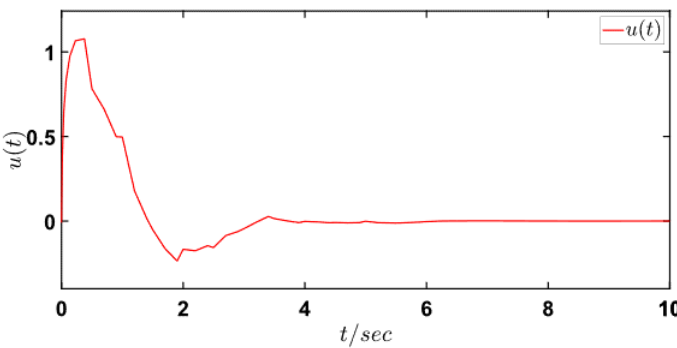
Figure 4. The control input.